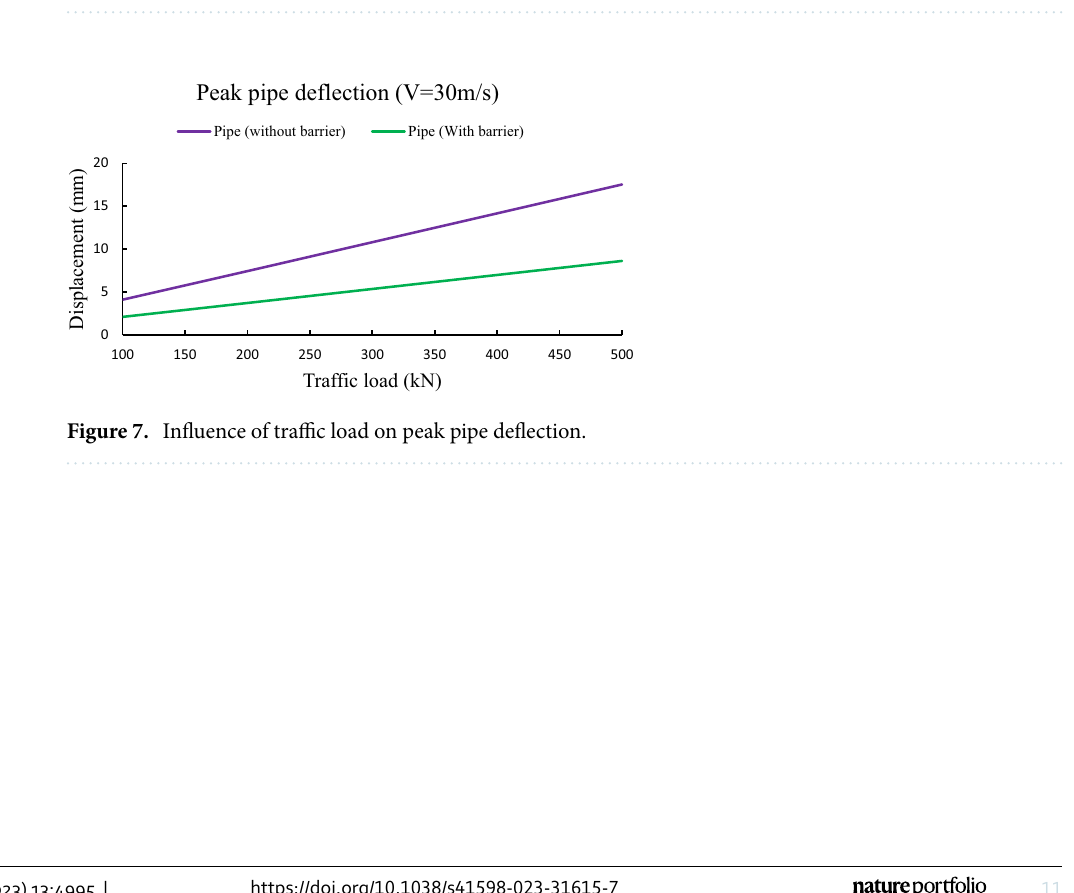
Figure 6. Mid span deflection time history of ( a ) all the beams and ( b ) bottom beam (pipe) for both with and without barrier system.